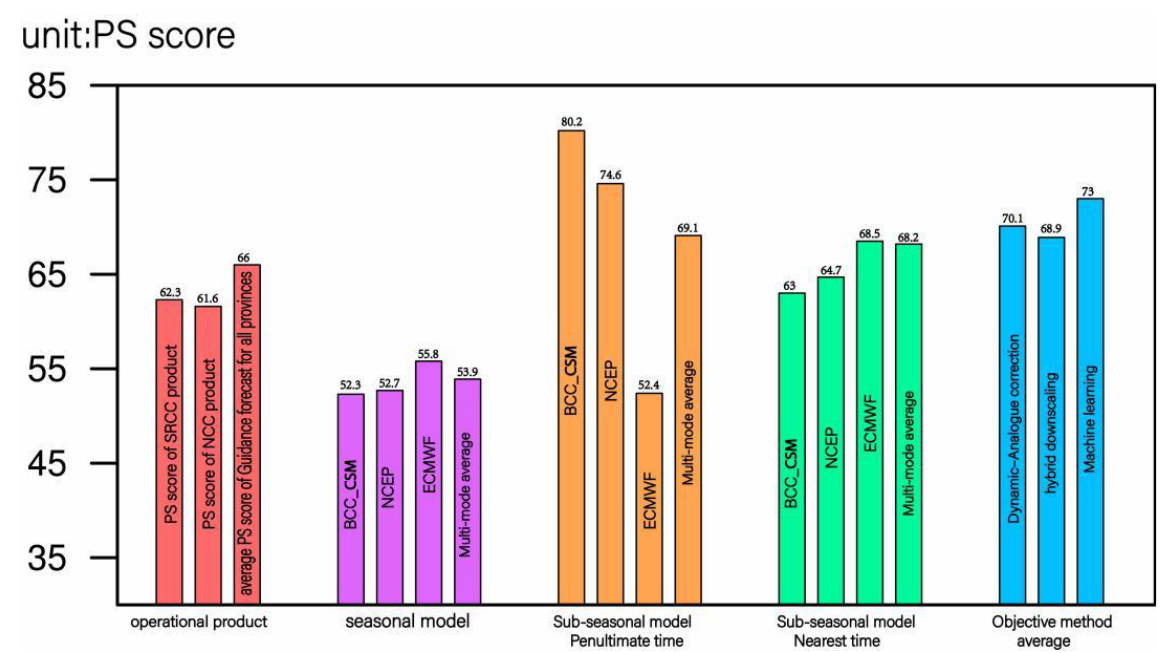
Figure 5. PS scores of August precipitation forecasts from different schemes.